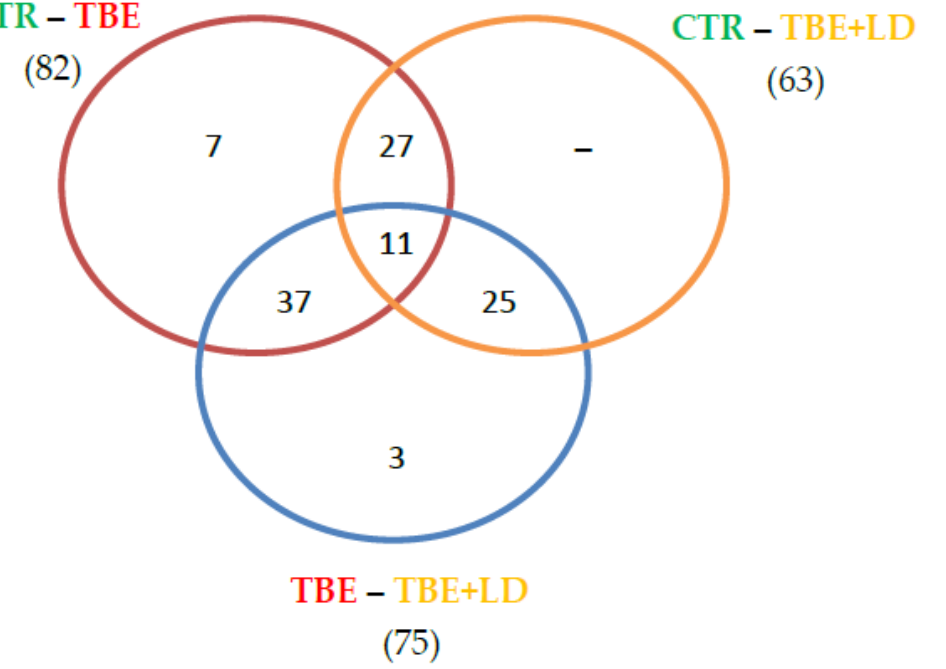
Figure 1. The distribution of the significantly changed proteins between each pair of the analyzed groups: control (CTR), patients with tick-borne encephalitis (TBE), and patients with TBE and co-infection (TBE+LD).